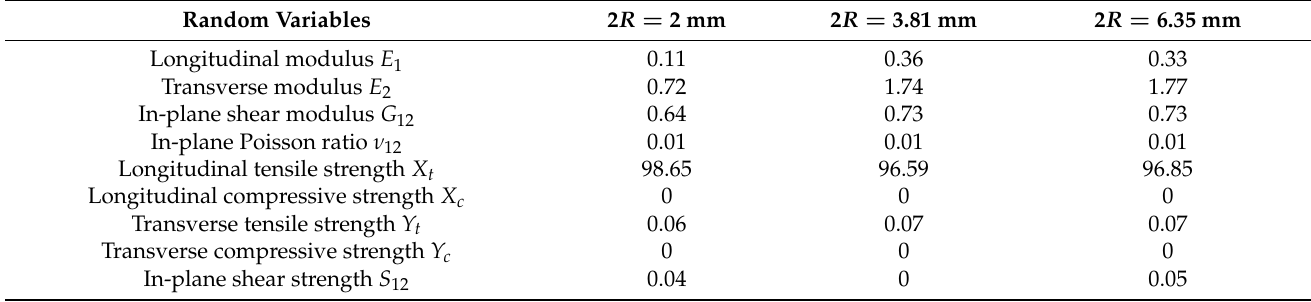
Table 4. Importance factors regarding material properties for [ 45 ◦ /0 ◦ / − 45 ◦ /90 ◦ ] laminate